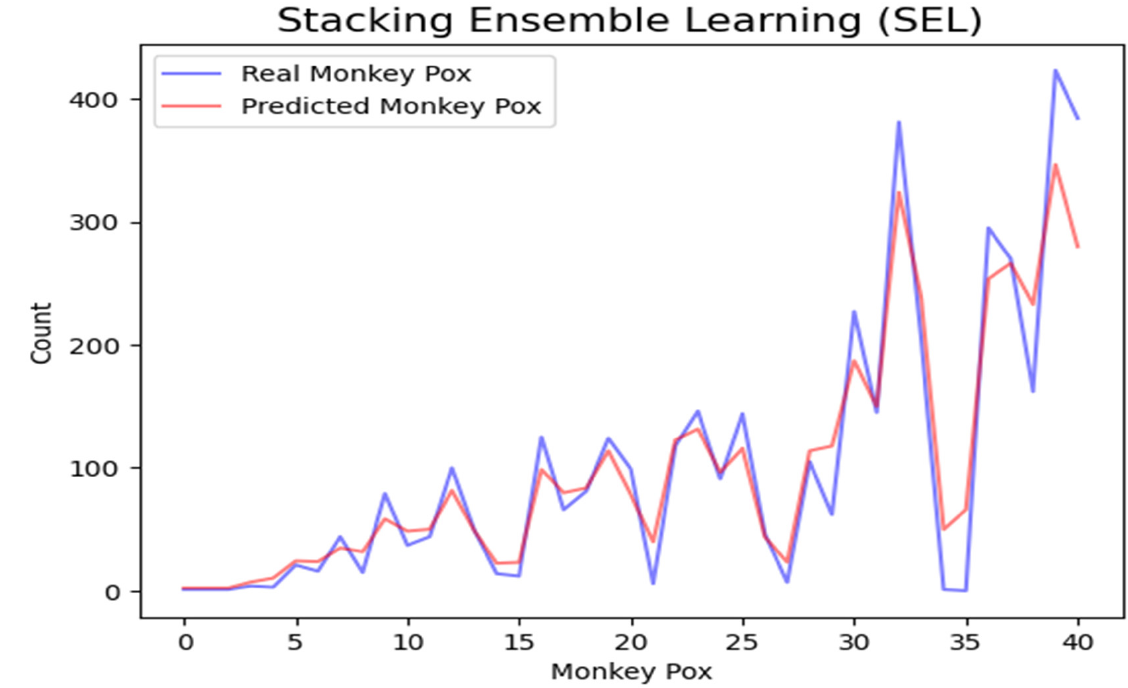
Figure 15. Time Series of Stacking Ensemble Learning (SEL).